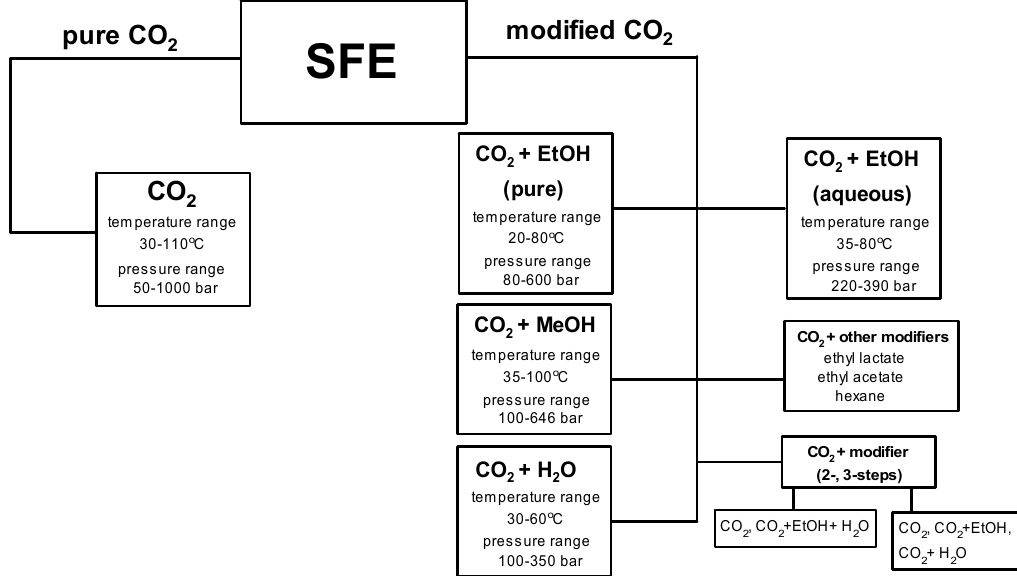
Figure 5. Application of SFE in phenolic compounds extraction from plant materials.